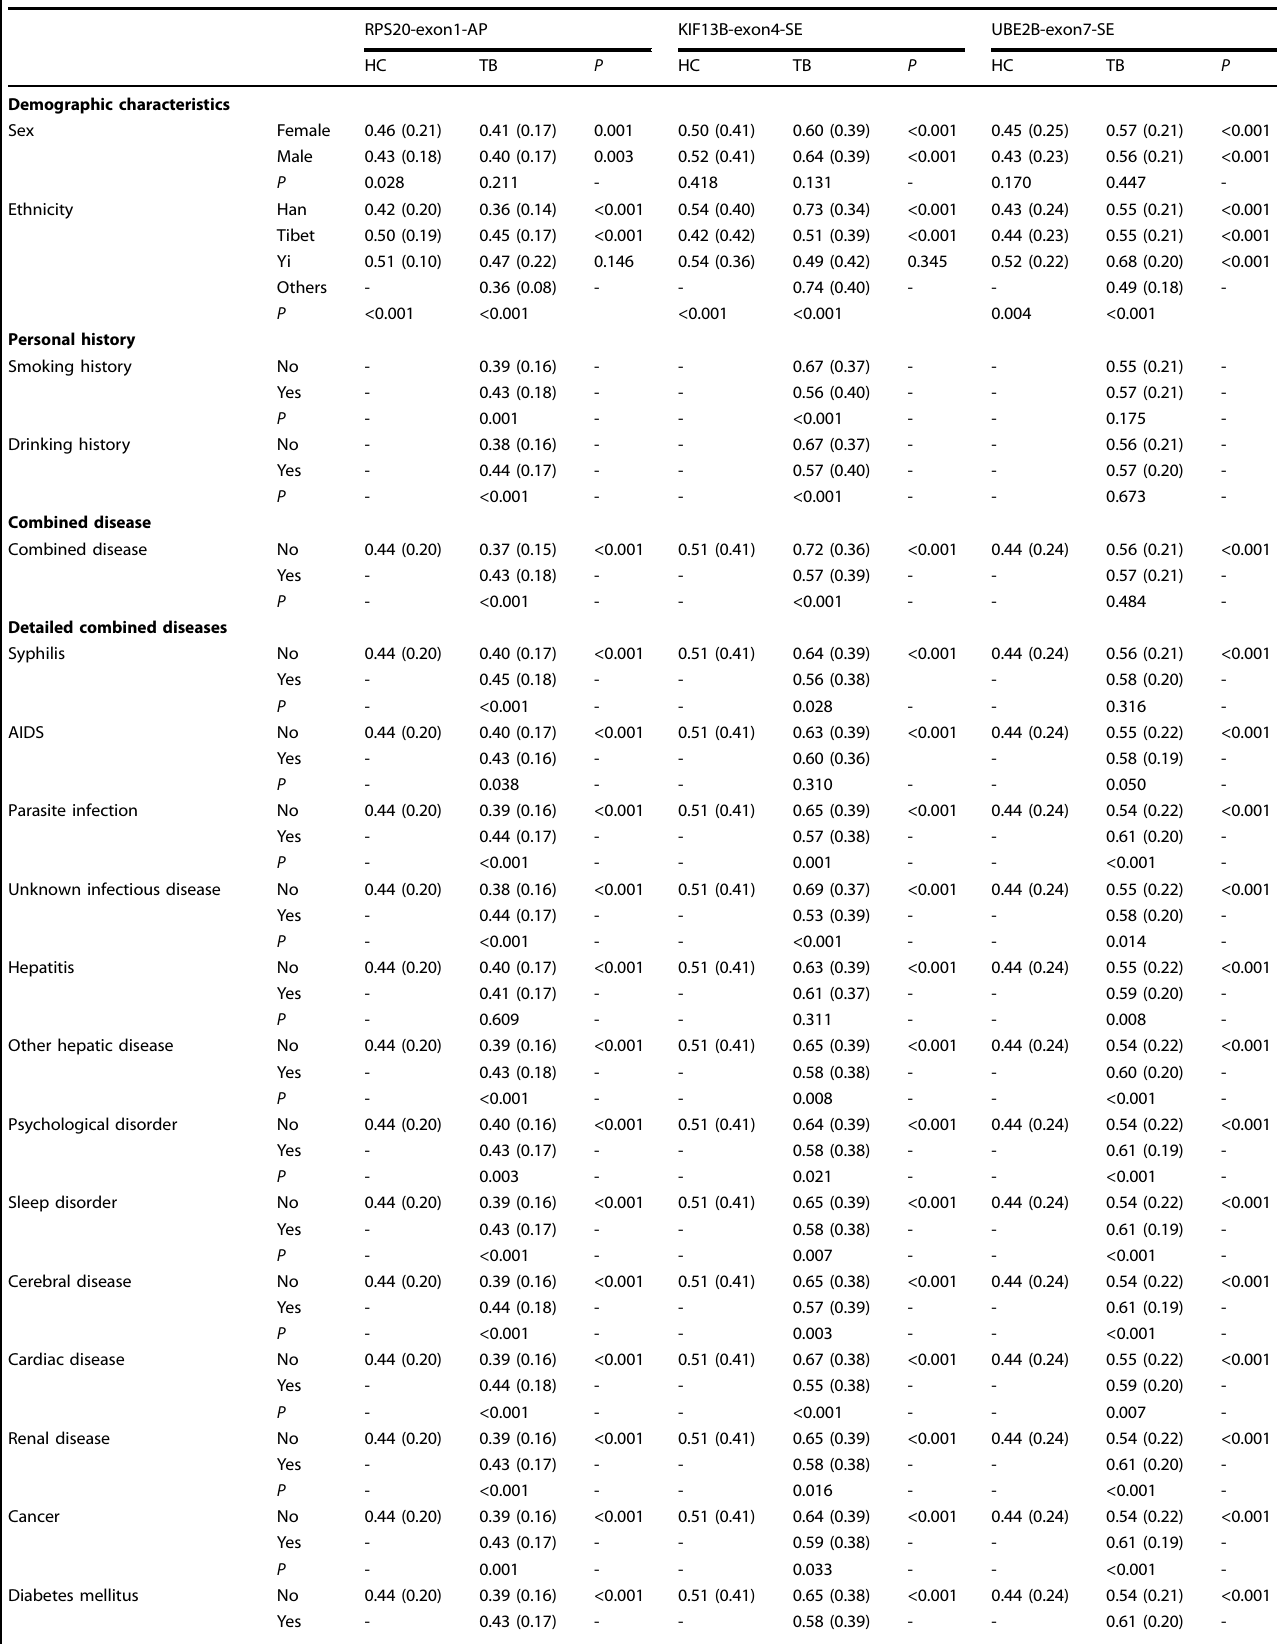
Table 2. The results of subgroup